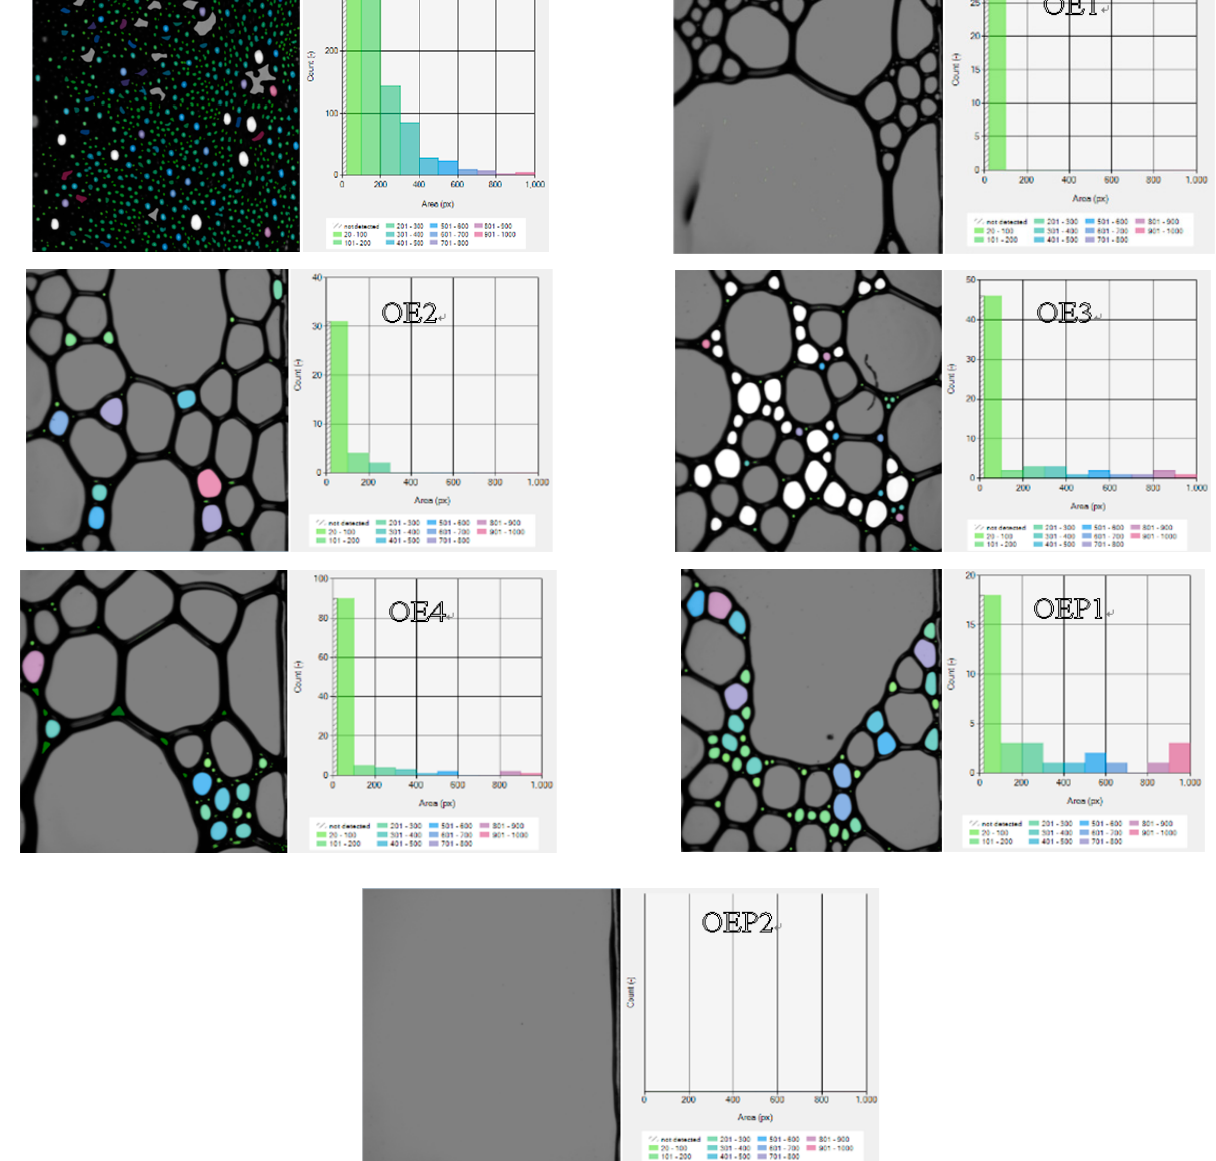
Figure 6. Photographs and size distribution columns of the solutions of the polycarboxylate superplasticizer mixed with various defoamers at the total time of 700 s.